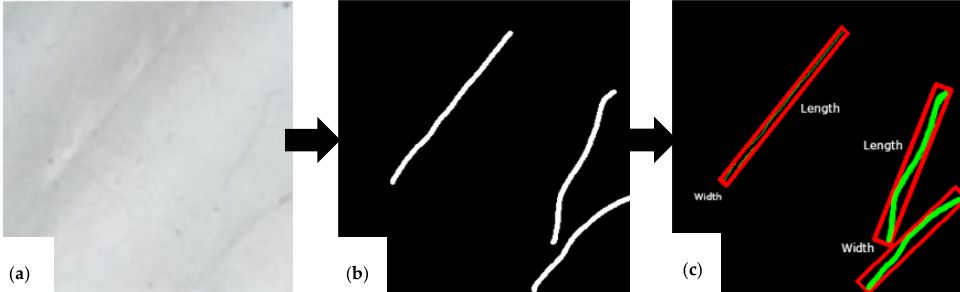
Figure 9. ( a ) drone image. ( b ) data labelling. ( c ) cracks length and width estimation.